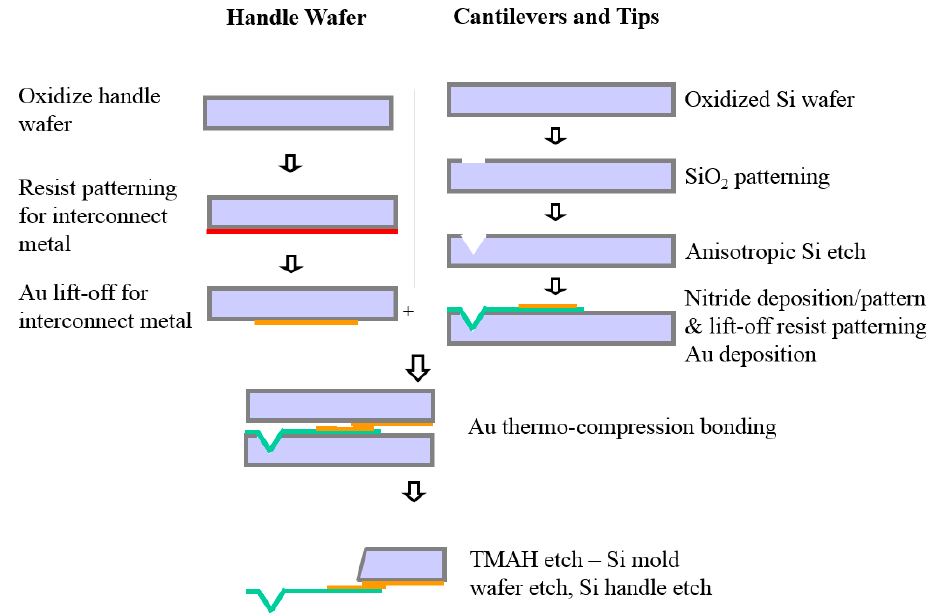
Figure 4. Cross-sectional view of the microcantilever fabrication scheme.